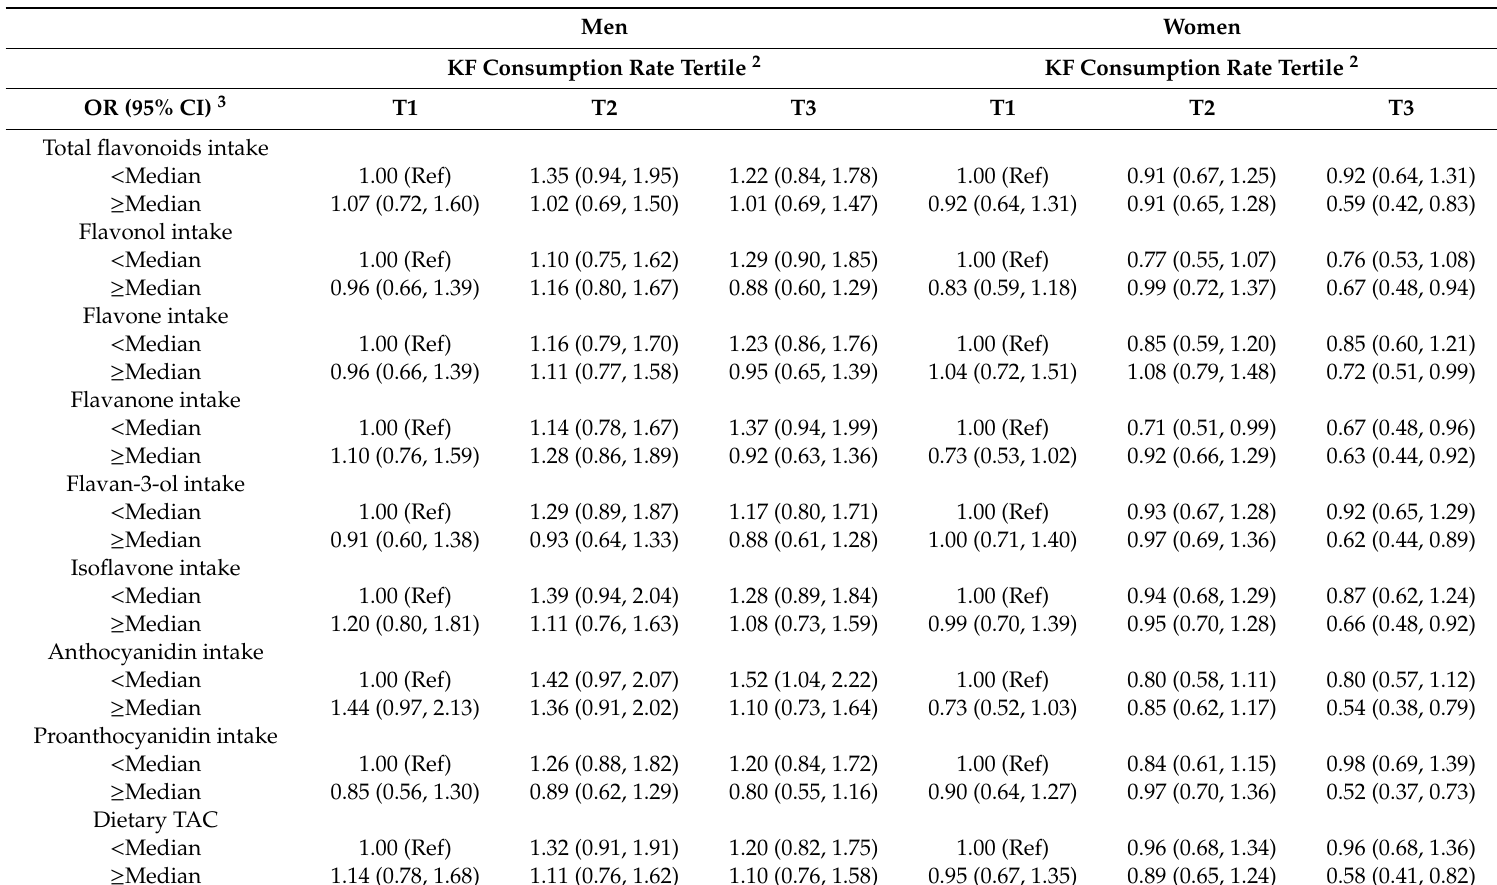
Table 4. Odds ratios (ORs) and 95% confidence intervals (CIs) of elevated C-reactive protein levels according to Korean food (KF) consumption rate tertile group and flavonoid intake or dietary total antioxidant capacity (TAC) 1